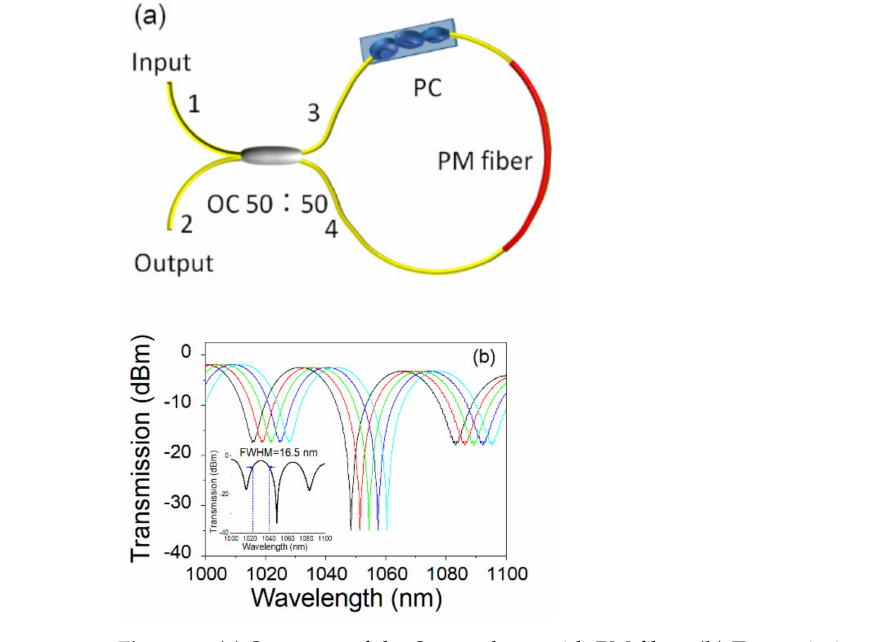
Figure 2. ( a ) Structure of the Sagnac loop with PM fiber; ( b ) Transmission spectra of Sagnac loop when the polarization controller change, inset: the initial state of the Sagnac